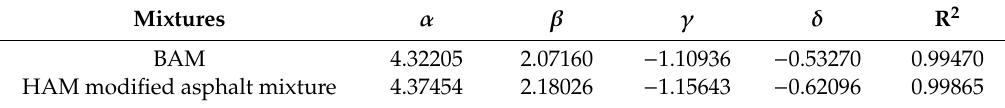
Table 7. Fitting parameters of dynamic modulus master